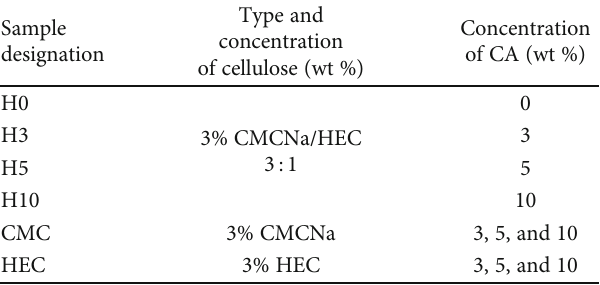
Table 1: Composition of the hydrogel samples.